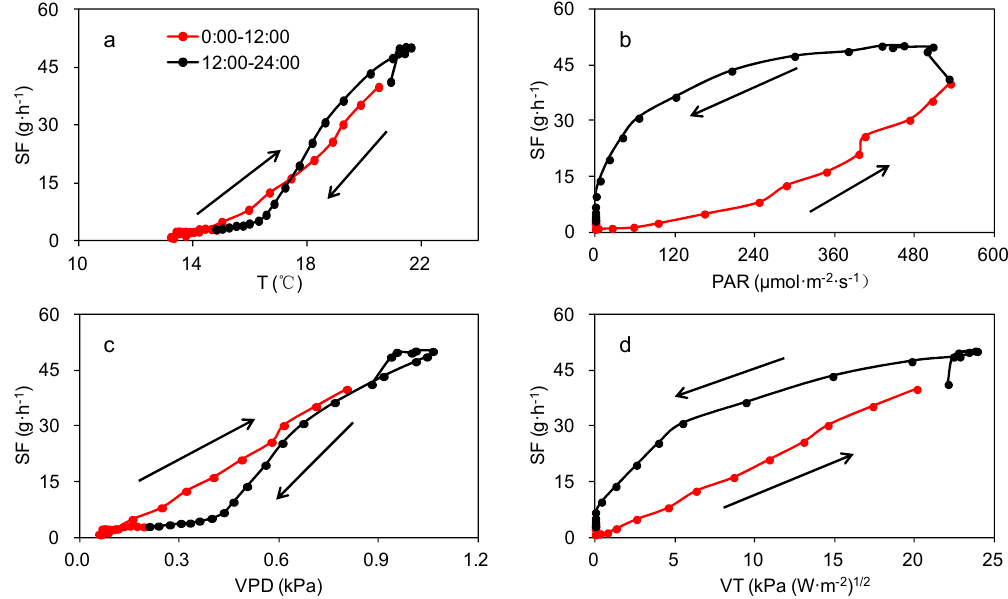
Figure 4. Hysteresis loops between the 0.5-hourly mean SF and ( a ) air temperature (T), ( b ) photosynthetically active radiation (PAR), ( c ) vapor pressure deficit (VPD), and ( d ) variable of transpiration (VT). Note that the arrows on the plots denote the sap flow change direction with time.